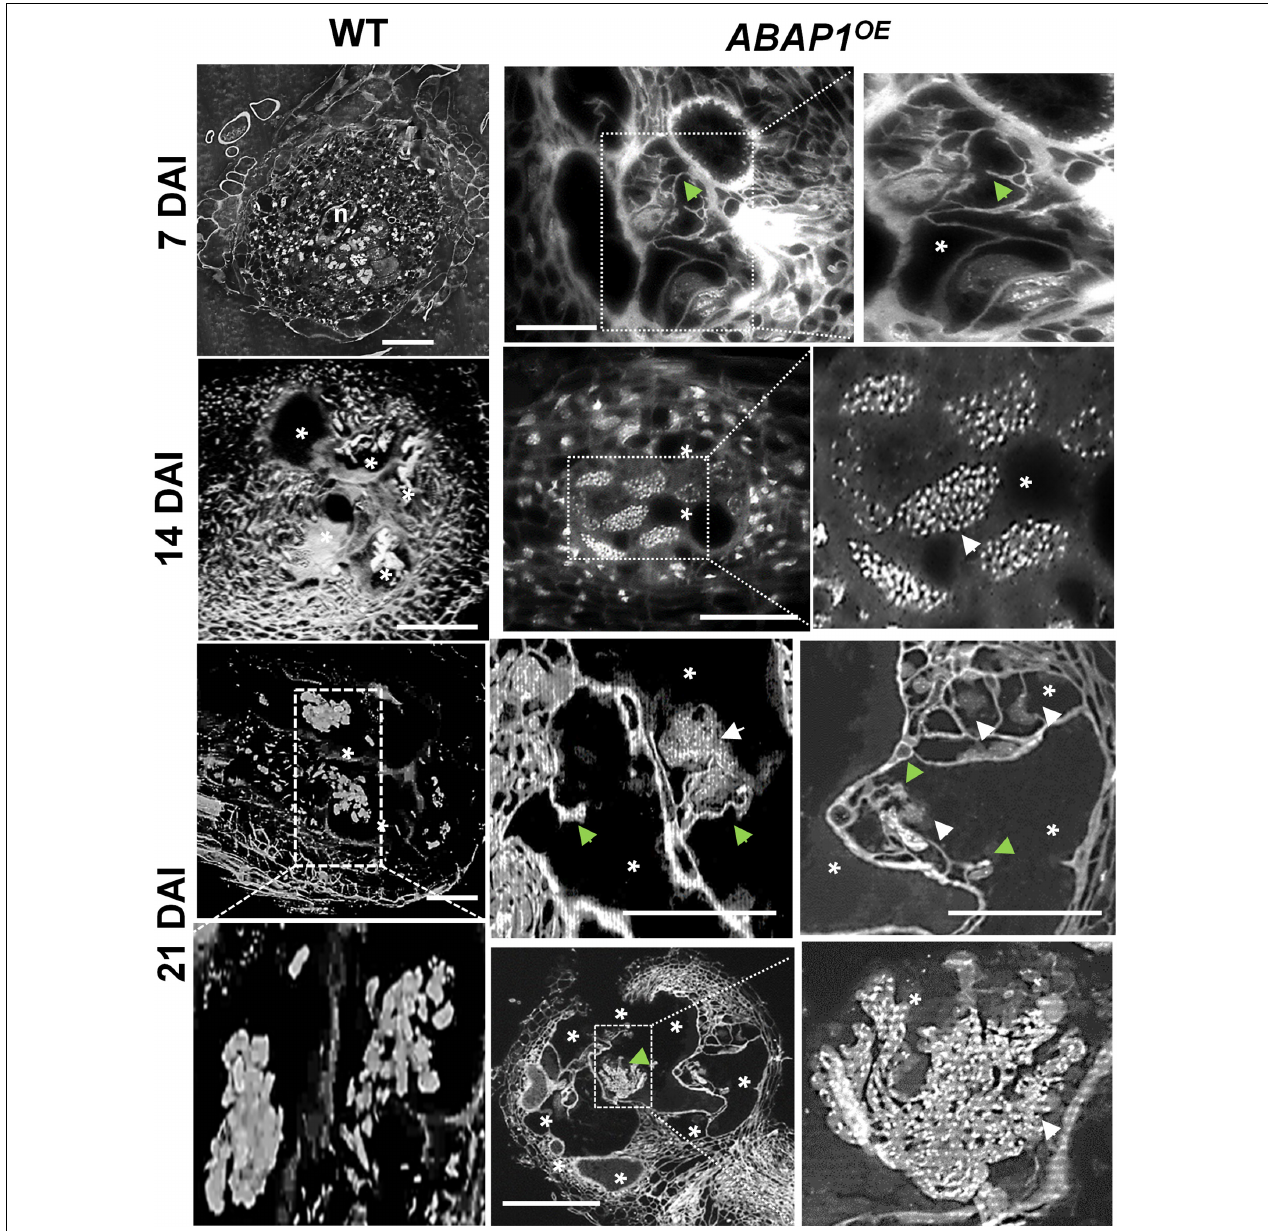
FIGURE 6 | ABAP1 overexpression induces nuclear morphology changes in root-knot nematode-induced giant cells. Gall nuclei from ABAP1 OE and wild-type (WT) plants, stained with 4,6-Diamidino-2-phenylindole (DAPI), were observed under dark-field optics. Numerous large stained nuclear dots (white arrows) likely illustrate condensed chromatin at different stages of gall development (7, 14, and 21 DAI). Abnormal cell wall stubs (green arrows) were also seen in ABAP1 OE galls. Strong cellular and nuclei phenotypes in mature galls suggest cumulative mitotic defects upon ABAP1 overexpression. DAI, days after inoculation; asterisk, giant cell; n, nematode. Scale bars = 50 µ